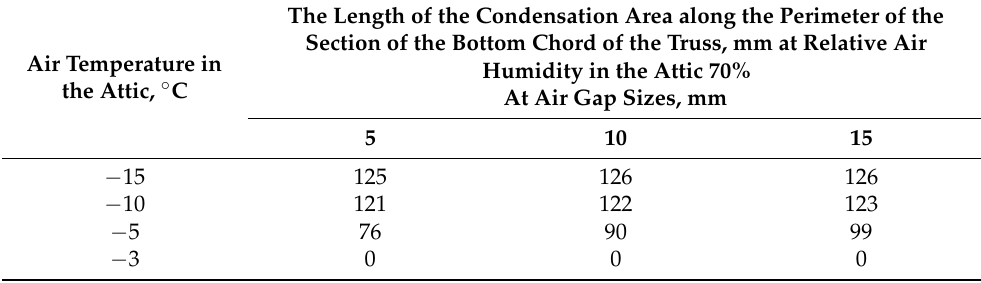
Table 4. The length of the condensation area along the perimeter of the section of the bottom chord of the truss, depending on the temperature and relative humidity of the air in the attic (calculation scheme with a gusset plate: detachment of the finishing layer from the elements of the bottom chord of the truss).